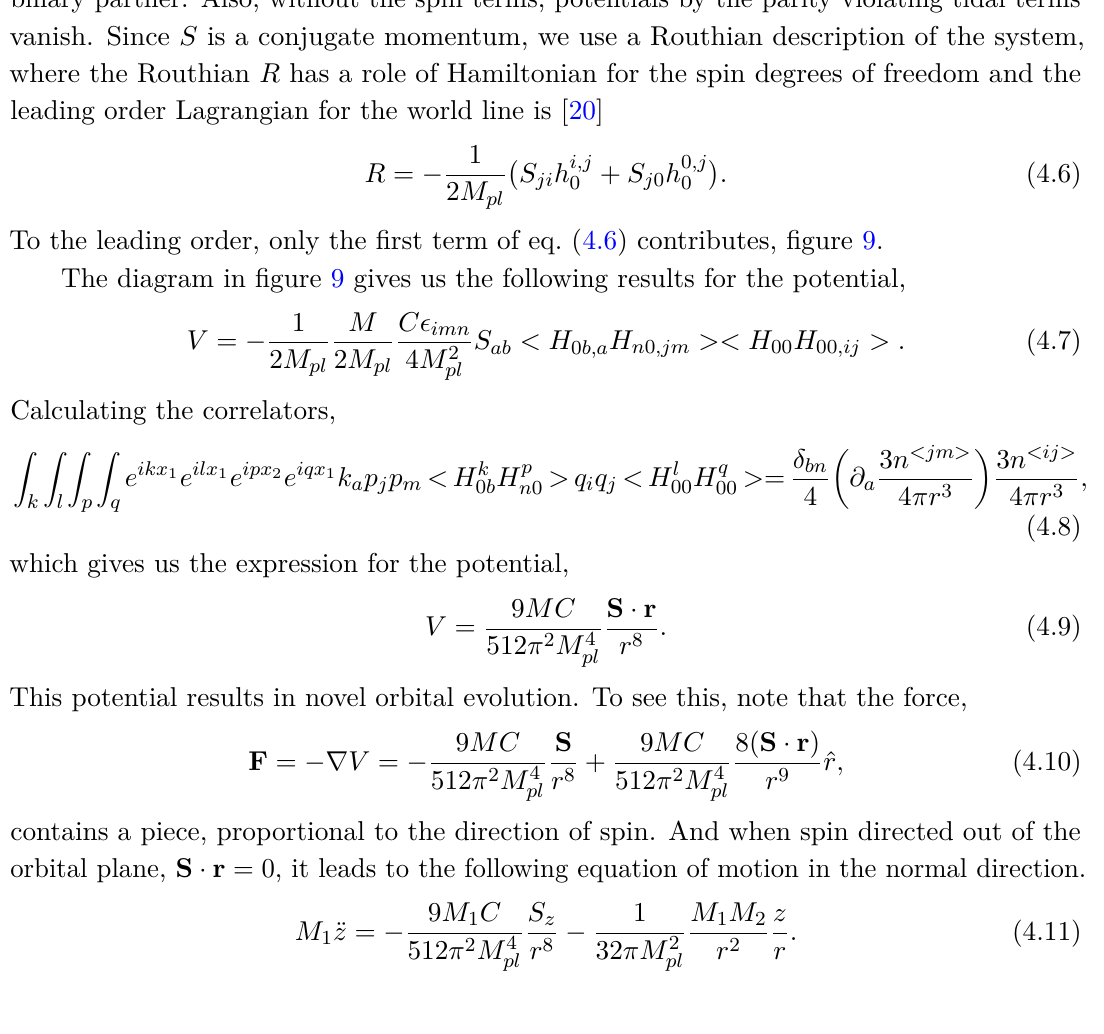
Figure 9 . Leading Order Spin+EB